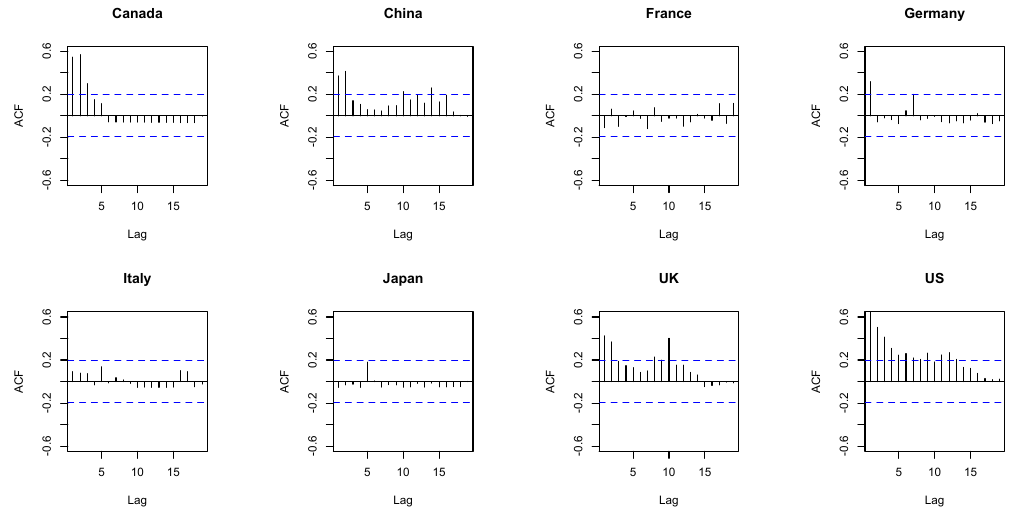
Figure 6. Autocorrelation functions of international spillovers. Dashed horizontal lines: bounds of the 95% confidence